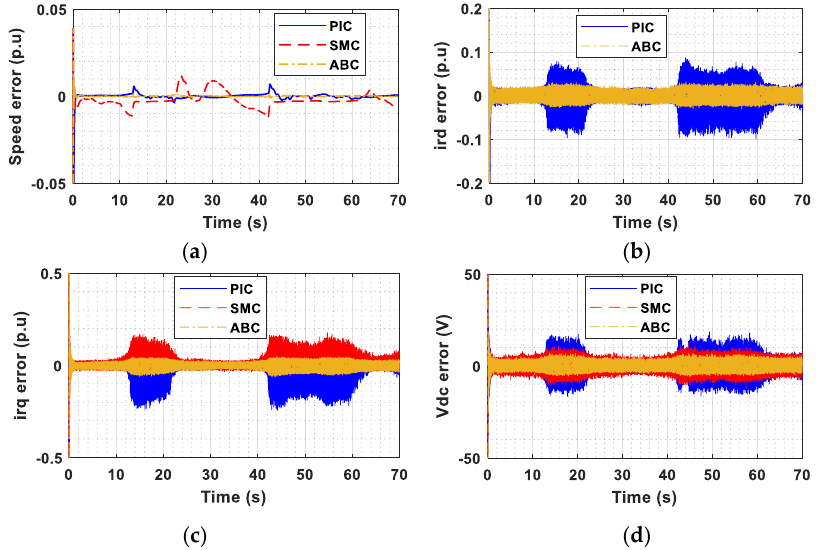
Figure 11. Controllers’ performance in (p.u); ( a ) Generator speed error ( b ), d-axis rotor current error, ( c ) q-axis rotor current error, and ( d ) Capacitor voltage error.